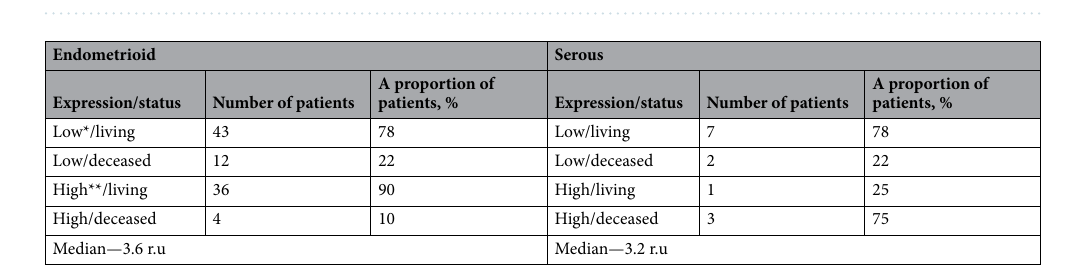
Table 1. A survival analysis, based on the intensity of a STK4 protein signal. r.u. relative units. *Low < median. **High > median.